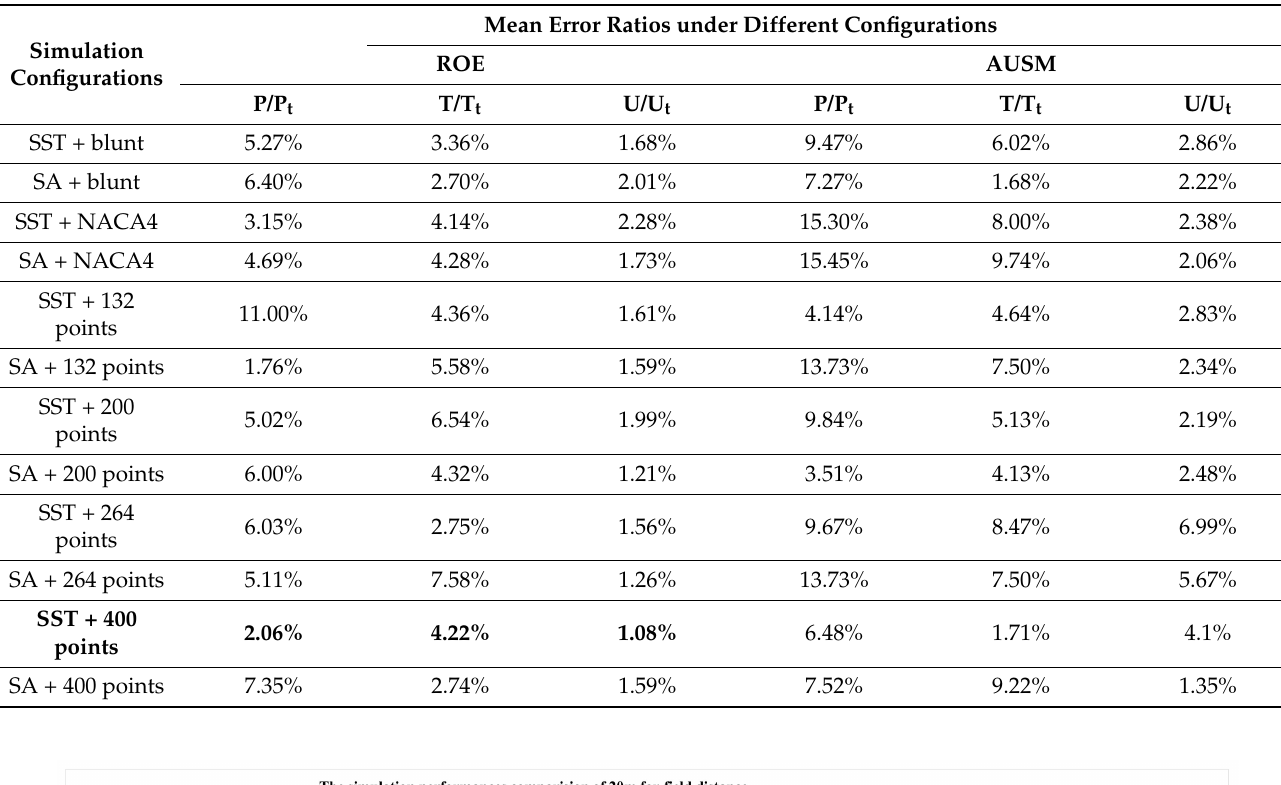
Table 20. The mean error ratios of P/P t , T/T t , and U/U t of the 20 m far-field distance.